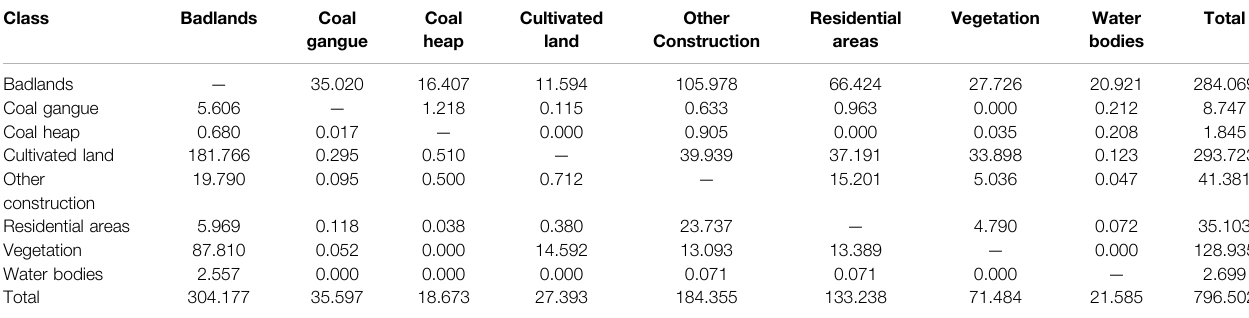
TABLE 8 | Land-use class change matrix from 1979 to 2003 (unit: 10 – 2 km 2 ).